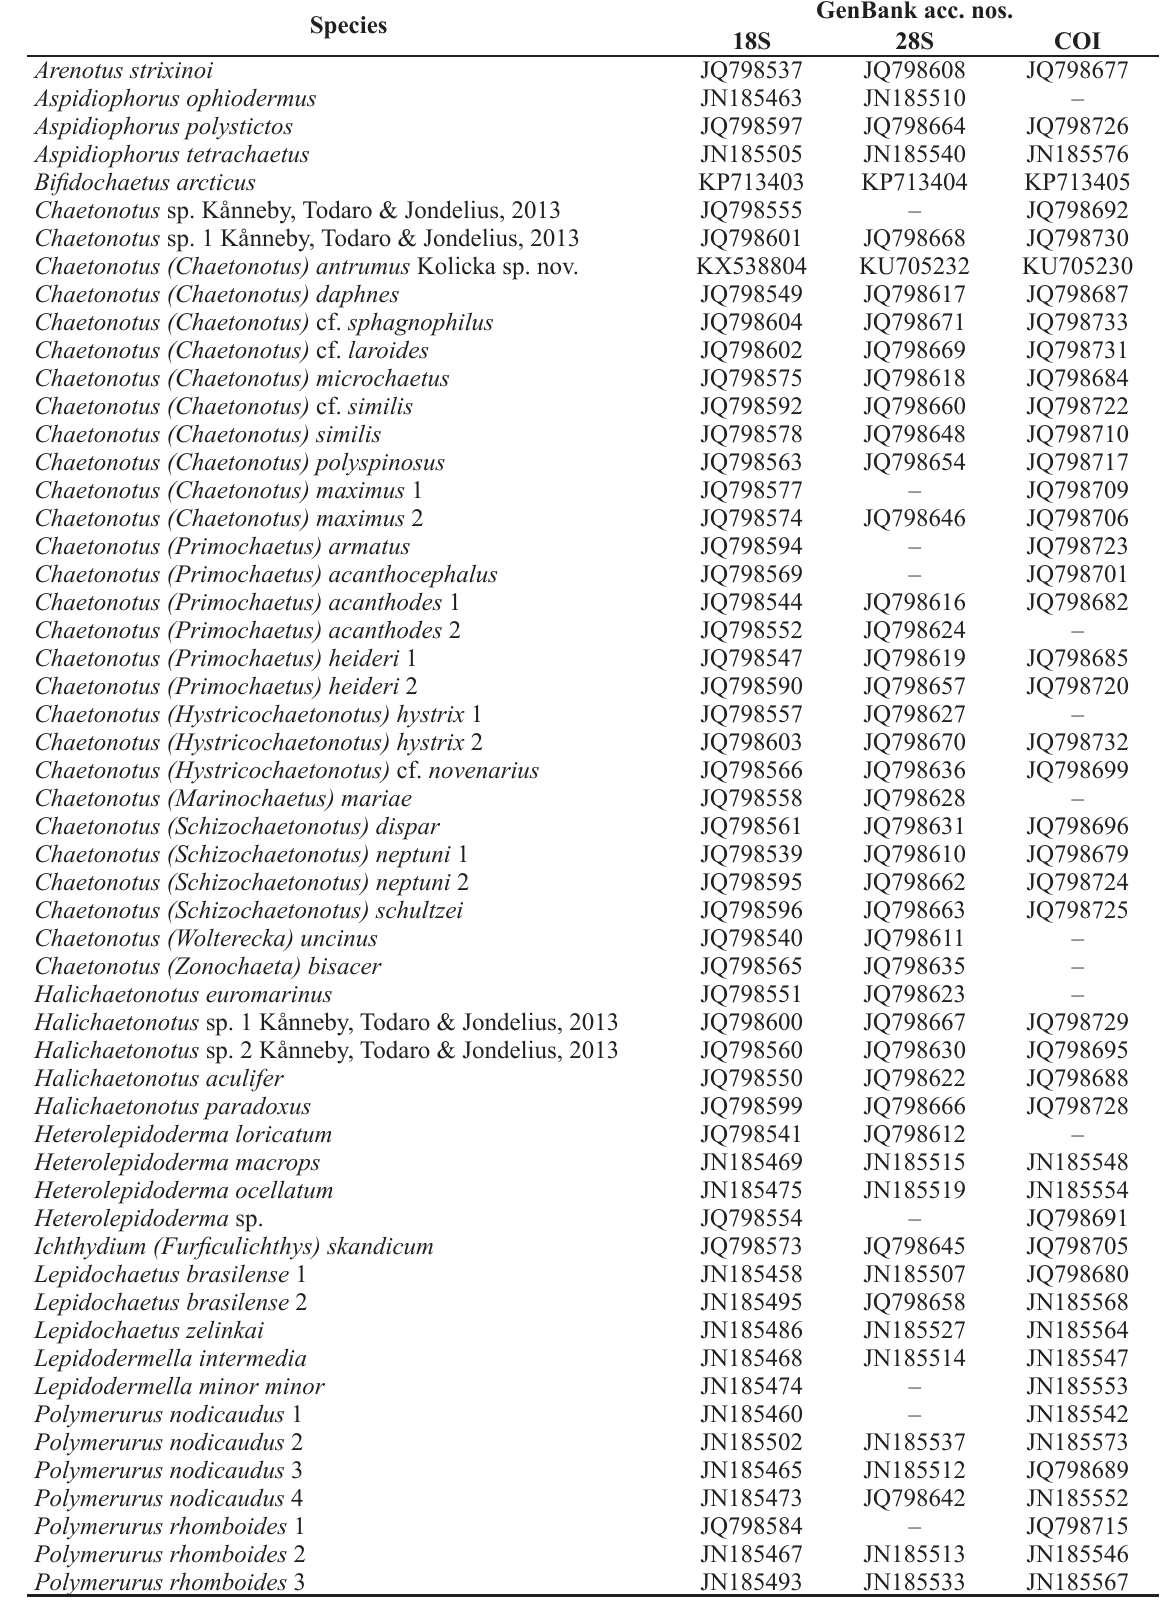
Table 3. DNA sequences of the gastrotrichs species used in phylogenetic analysis.